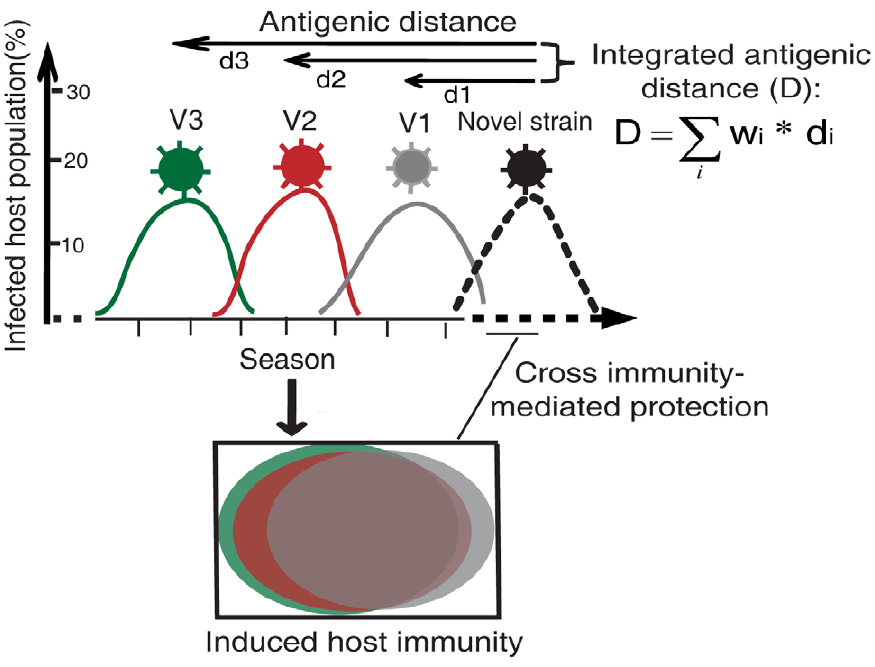
Figure 1. A simplified host-virus interaction model. The V1. V2, V3, … represent the first, second, third, … antigenic strain that circulated prior to a novel antigenic strain. To represent the ability of a novel strain to escape the pre-existing human immunity, we introduce a metric, integrated antigenic distance (D), as a linear combination of the antigenic distances between the novel virus and its previous antigenic strains (d).